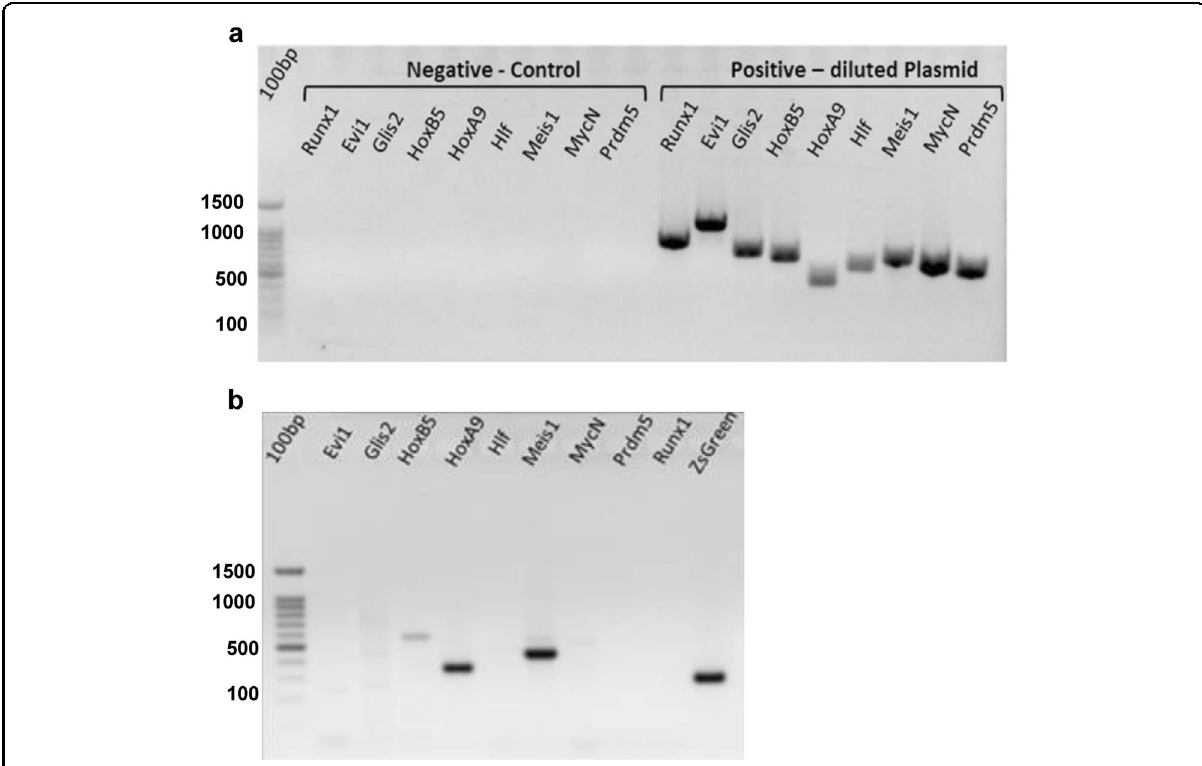
Fig. 3 Using polymerase chain reaction (PCR) analysis to identify the driving oncogenes in the leukemic lines. a Control PCR w/o leukemia- line DNA, or diluted plasmids (1 ng). b PCR of ML23 detecting HoxB5 , HoxA9 , and Meis1 oncogenes. The 100-bp ladder is on the left lanes. Data are from one of at least three independent experiments ( n =